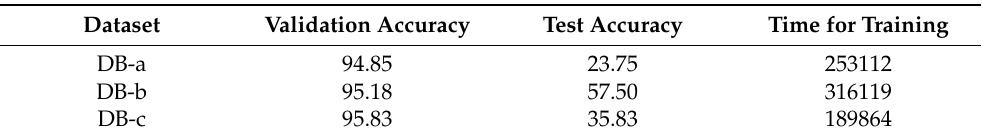
Table 8. Classification validation and test accuracy (%) and time for training (ms) on new subject on CapgMyo with pretrained model by supervised learning.